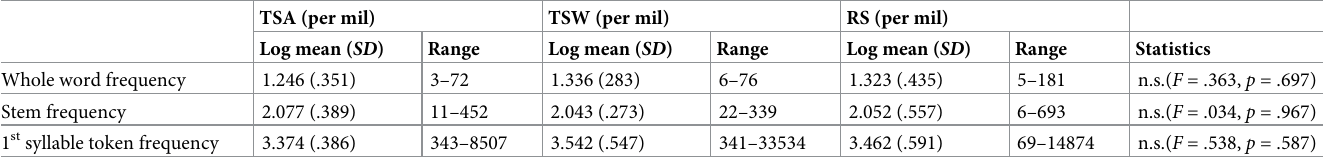
Table 1. Descriptive lexical variables by experimental